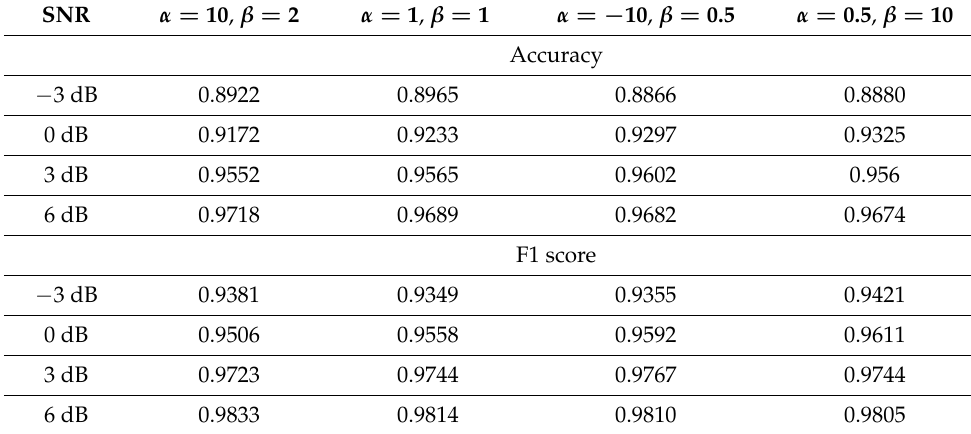
Table 9. Classification results for the second signal with proposed entropy measure and different parameter